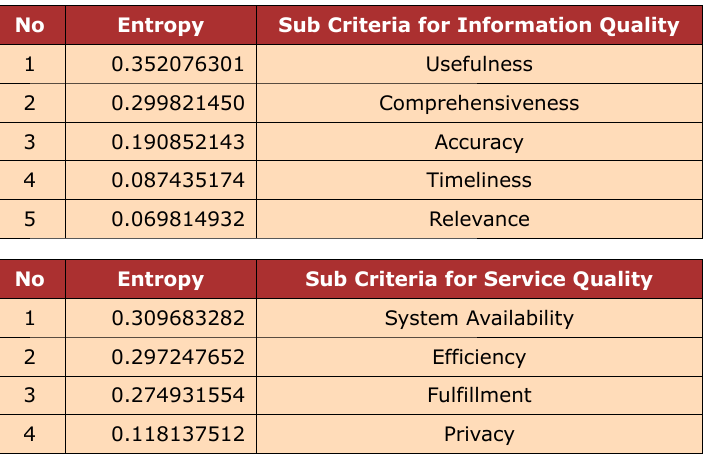
Table 4. Entropy value for sub-criteria